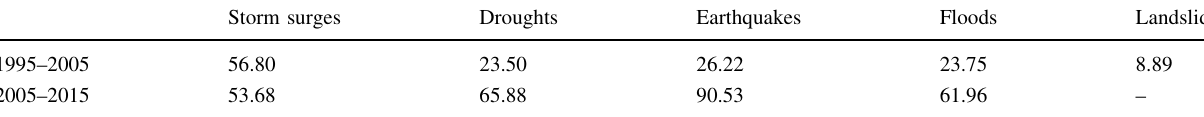
Fig. 6 Hot/cold spots of changes in built-up land exposure to hazards in China from 2005 to 2015. Jing-Jin-Ji: Beijing–Tianjin–Hebei region Table 5 Hot spots of changes (%) in built-up land exposure to different hazards in China from 1995 to